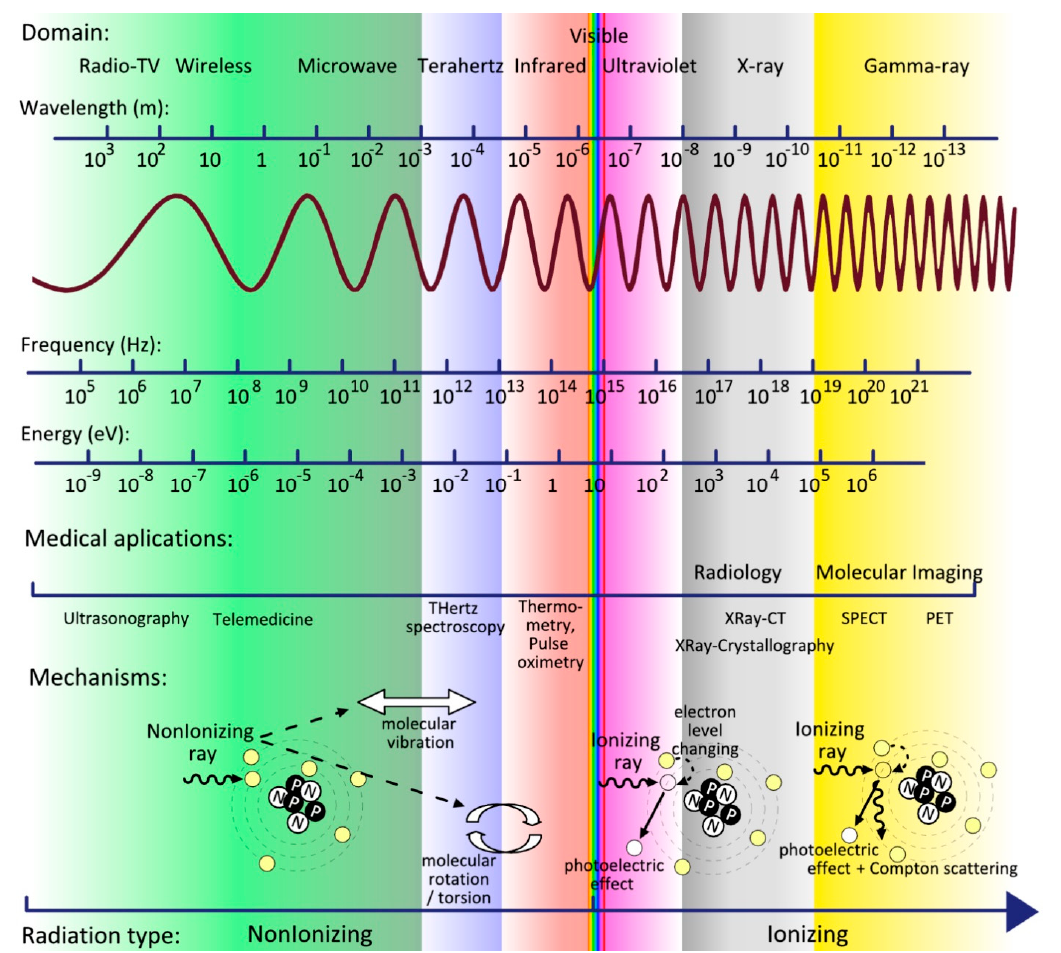
Figure 1. The spectrum of electromagnetic waves, characteristics, and medical applications.